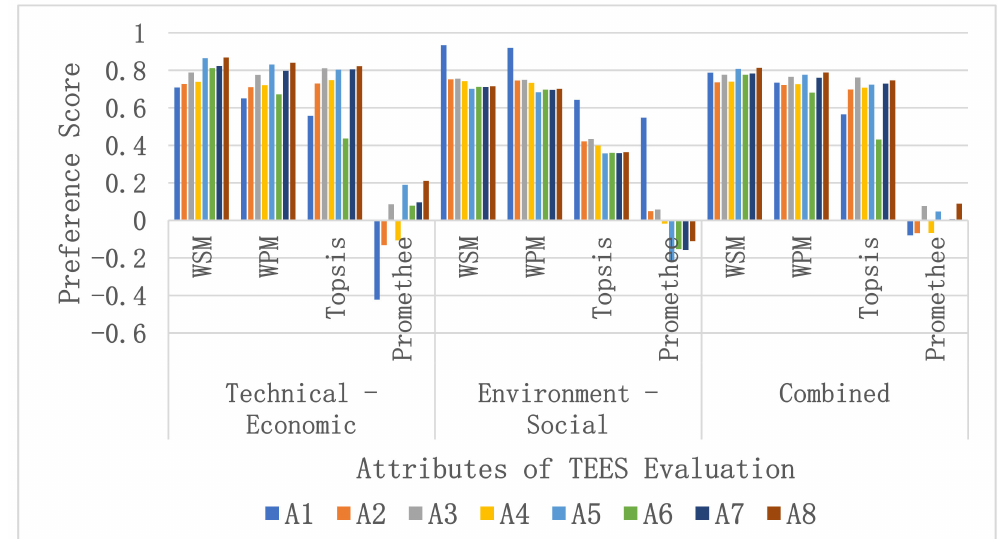
Figure 16. Attributes of TEES evaluation for C2/S3 for REG+D-STATCOM equal to the capacity of DGs only at 0.90 LPF in the 33-bus MDN under